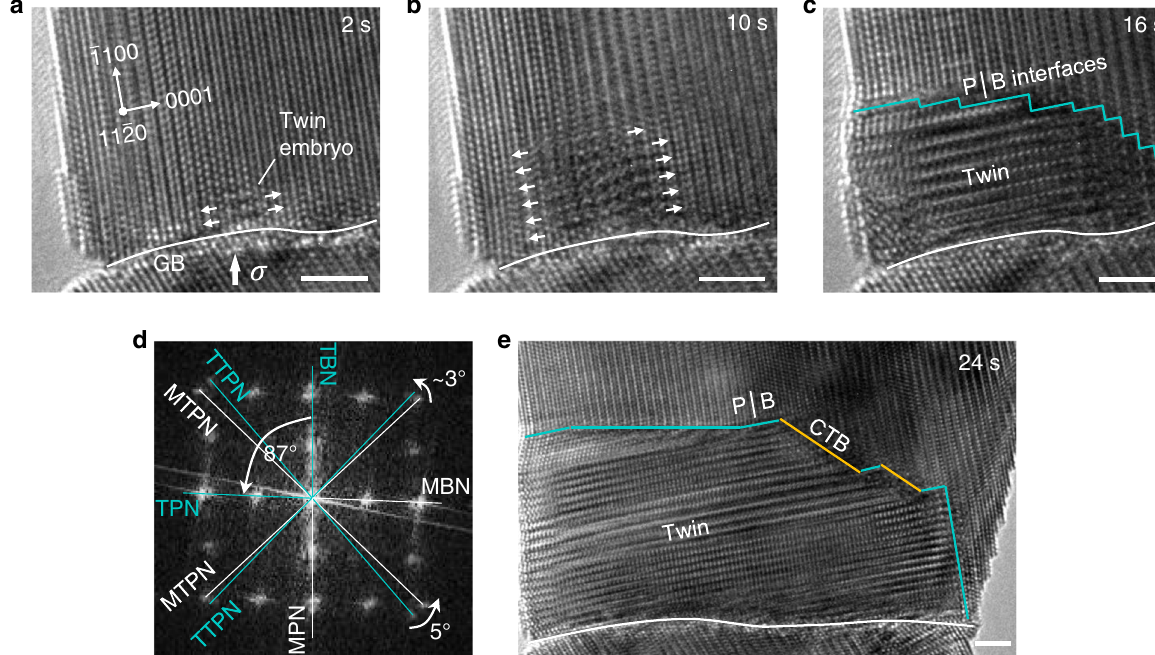
Fig. 1 Direct observation of a twinning nucleation process. a – c Sequential HRTEM images showing twinning nucleation in a HCP rhenium nanocrystal under < 1 − 1 0 0 > -oriented compression. Arrows indicate the expansion of basal layers in the twin embryo. Turquoise lines indicate the Prismatic │ Basal (P │ B) interfaces between the twin embryo and matrix. White lines indicate the grain boundary (GB). Block arrow in a indicates the loading direction. d Fast Fourier transformation of the twin embryo in c . TBN, MPN, TPN, MBN, TTPN, and MTPN mean the plane normal directions of twin basal, matrix prismatic, twin prismatic, matrix basal, twin twinning plane and matrix twinning plane, respectively. e Morphology of the twin as it grew. Yellow lines indicate the coherent twin boundaries (CTB). Scale bars in a – c , e , 2